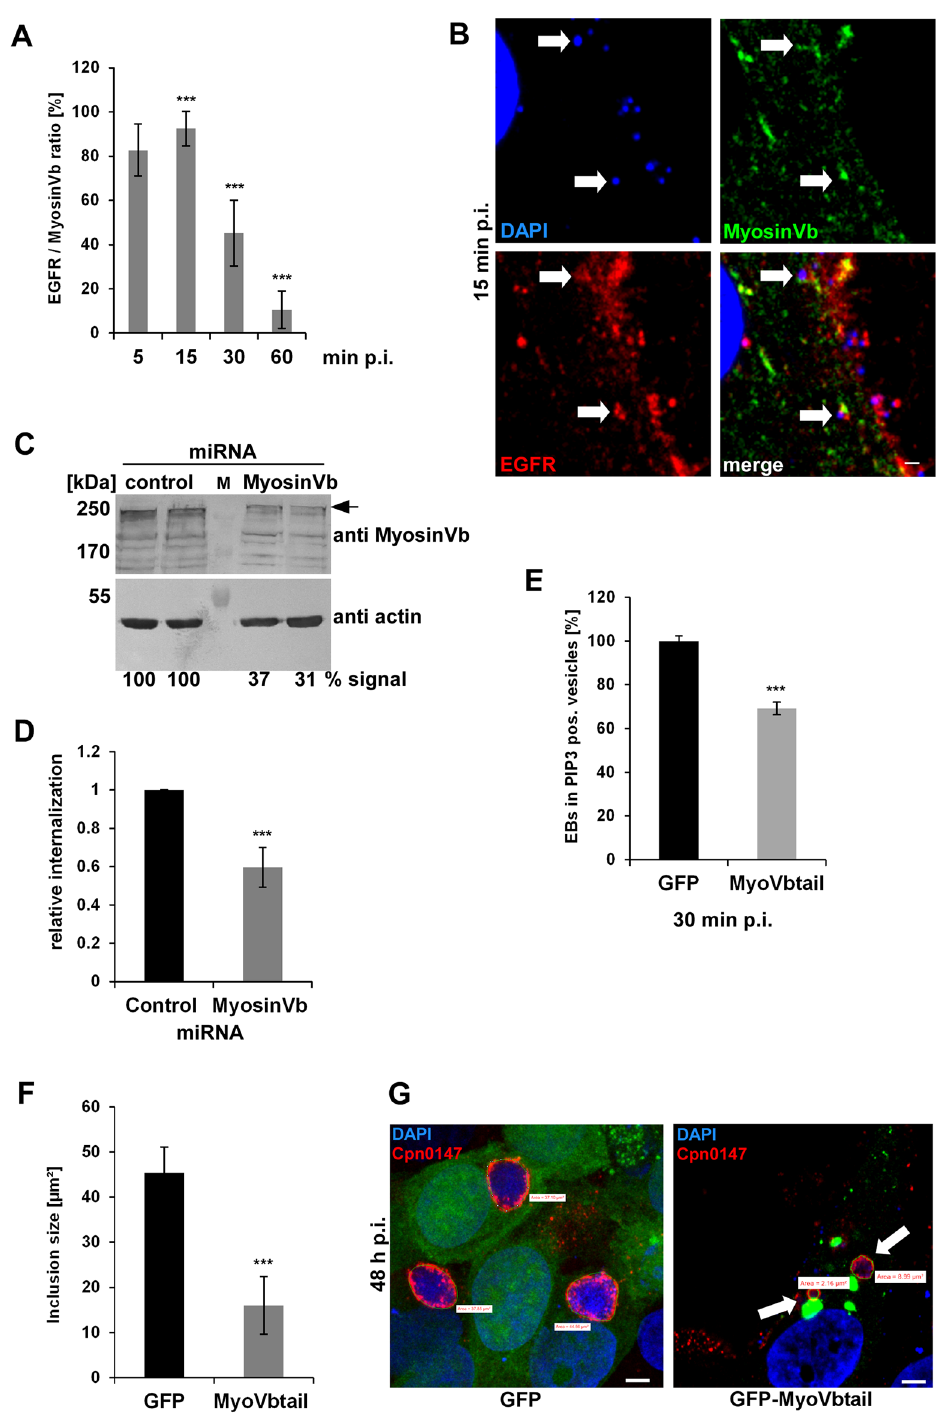
Fig 6. The acquisition of myosin Vb by the Rab11-Fip2 adaptor protein is essential for the C . pneumoniae infection. (A) Quantification of colocalization of EGFR-positive EBs with GFP-MyosinVb from 5 min to 60 min p.i. (n = 3). (B) Confocalimages of colocalization of GFP-MyosinVb and EGFR with C . pneumoniae EBs at 15 min p.i. White arrows indicatecolocalization. Bar 1 μ m. (C) Immunoblotanalysisof cells transientlytransfected for 72 h with control or myosin Vb miRNA plasmidsand lysed in phospho-Lysis buffer. Samples were fractionated by SDS/PAGE and probedwith antibodiesagainst myosin Vb to monitor knockdown; β -actinserved as loadingcontrol. The pixel intensity of bandswas analyzedwith ImageJ. The